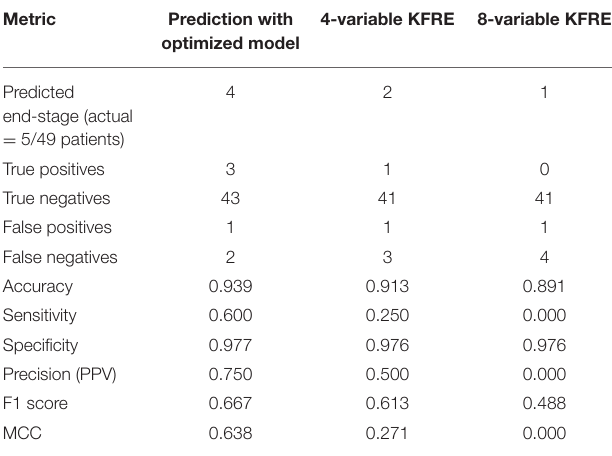
TABLE 4 | Comparative performance of 2-year ESKD predictions by optimized model and 4- and 8- variable KFRE.